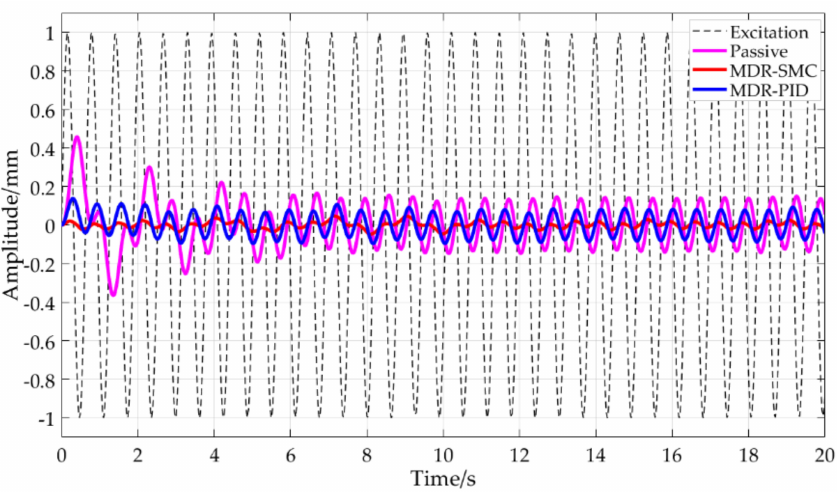
Figure 21. Comparison of the SMC with MRD, PID with MRD, and the passive system under excitation of a sinusoidal signal with an amplitude of 1 mm and a frequency of 10 rad/s.